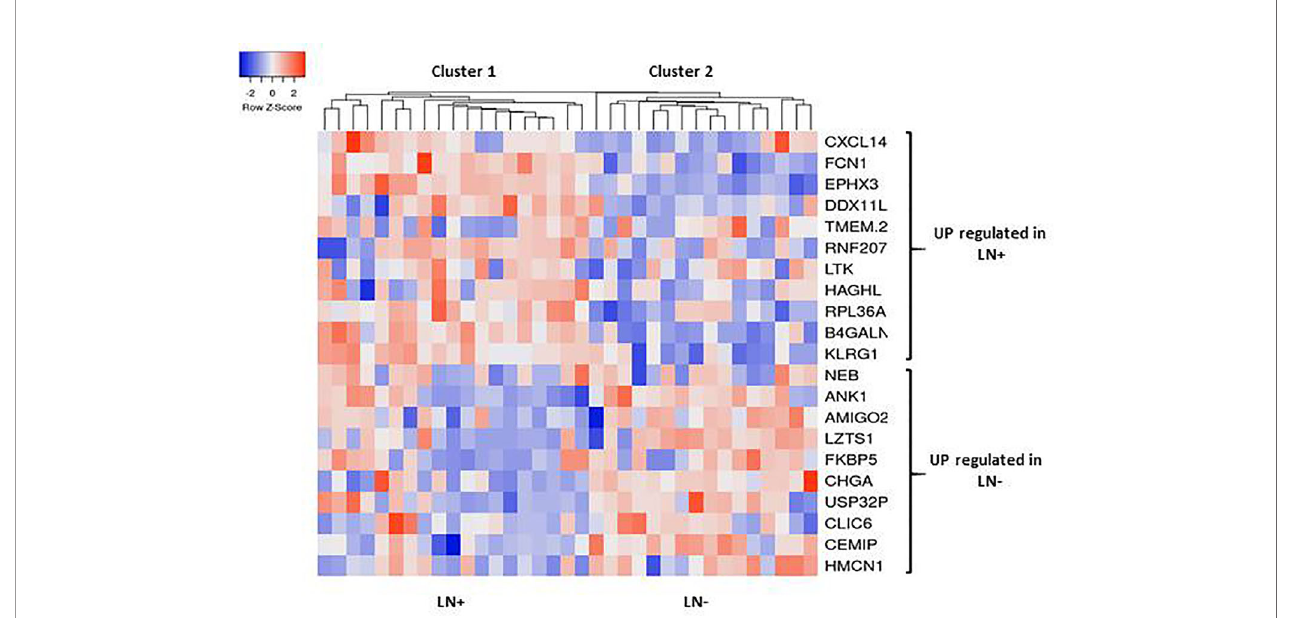
FIGURE 4 | Hierarchical clustering heat map of differential expressed genes (rows) between LN+ and LN- tumors. Red indicates high expression and blue low